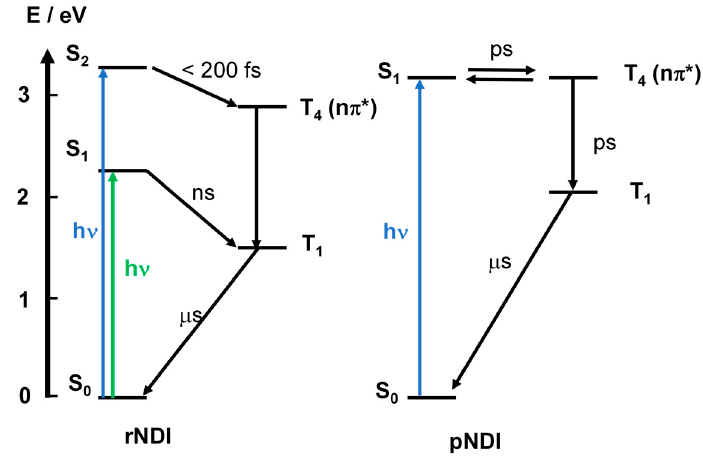
Figure 23. ISC mechanisms of the compounds rNDI and pNDI. Reproduced with permission from reference [110], copyright 2015, American Chemical Society.